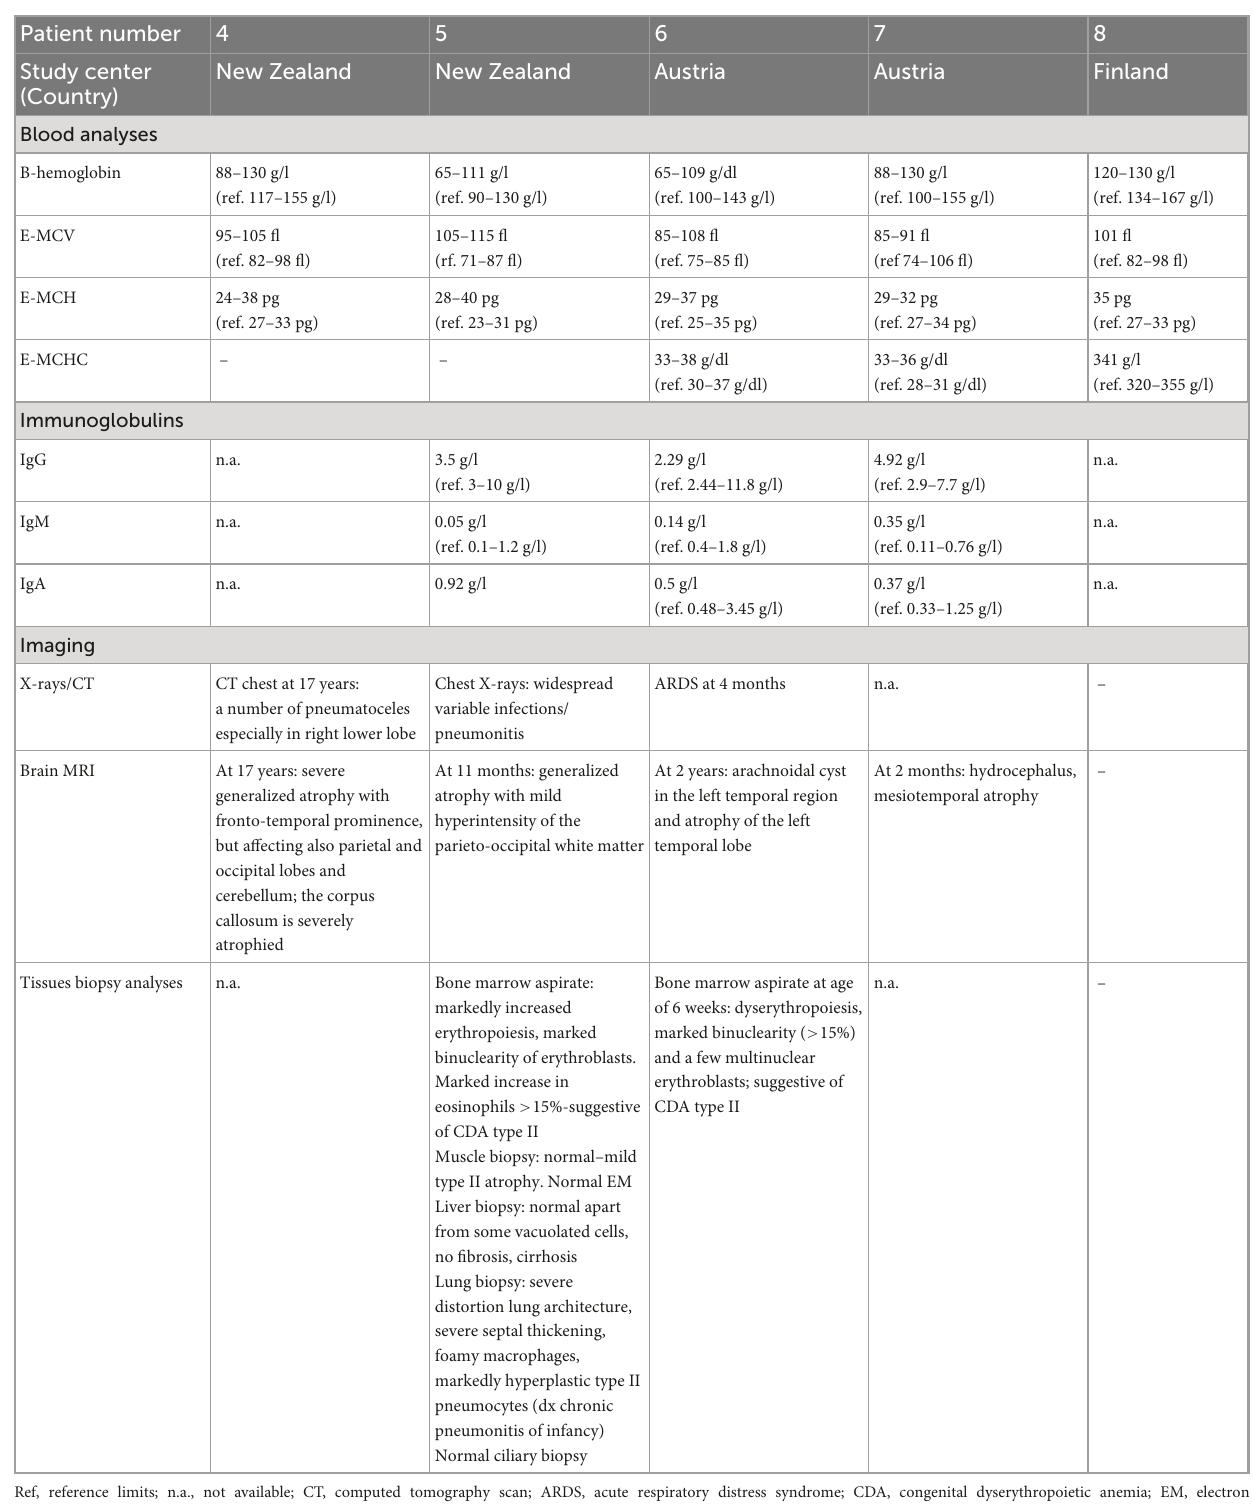
TABLE 2 Laboratory and imaging findings of five FINCA patients with the NHLRC2